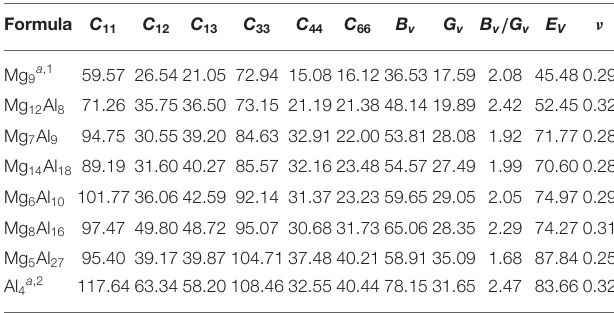
TABLE 2 | Elastic constants, bulk modulus B v (GPa), shear modulus G v (GPa), Young’s modulus E v (GPa), Pugh’s ratio ( B v / G v ), and Poisson’s ratio ν of Mg 12 Al 8